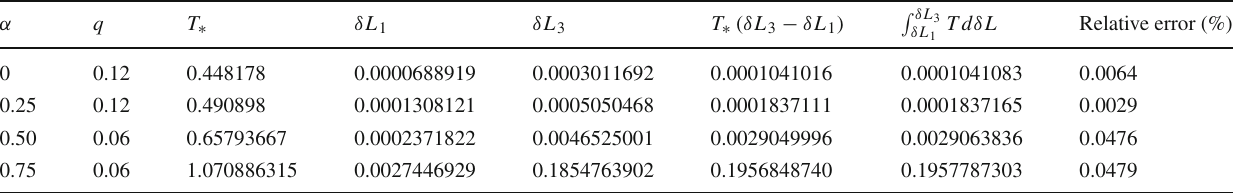
Table 2 Numerical check of equal area law in T – δ L graph for n = 4 ,θ 0 = 0 . 2 , l = 1 , b = 1 , k =